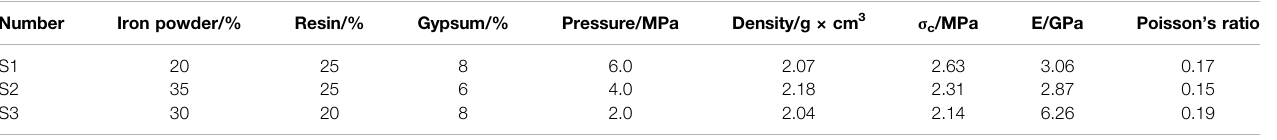
TABLE 1 | Proportion and mechanical parameters of the